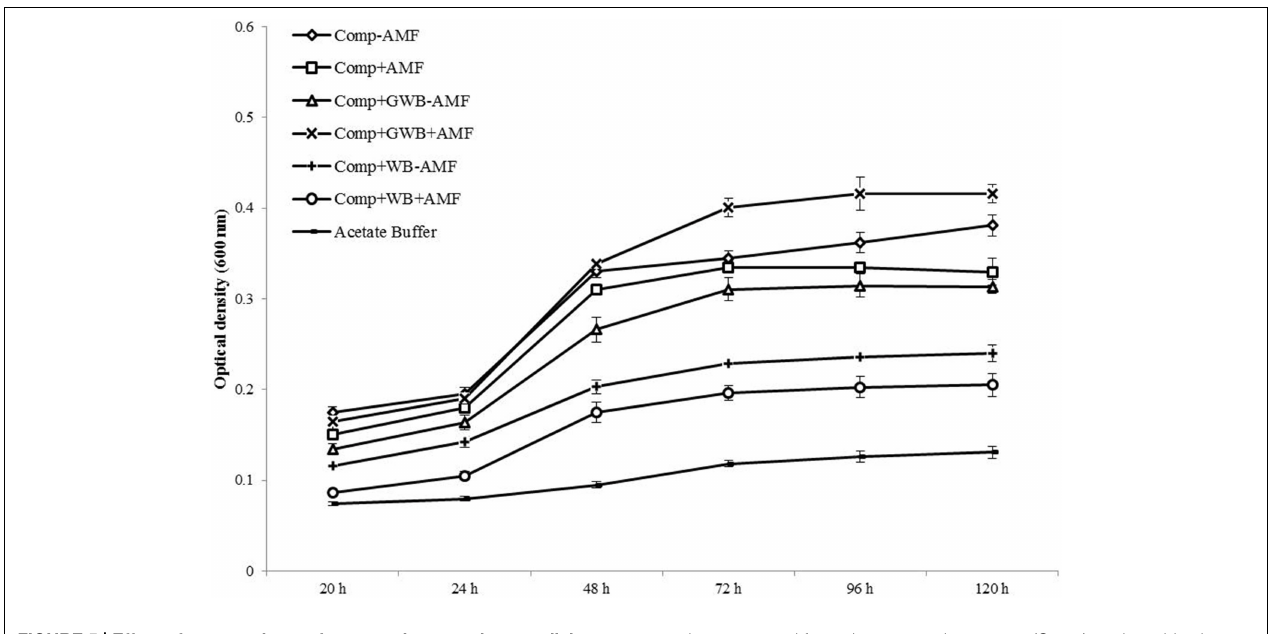
exudates extracted from plants grown in compost (Comp), and combination of compost with WB (Comp + WB) and with GWB (Comp + GWB), with ( + AMF) or without AMF ( −